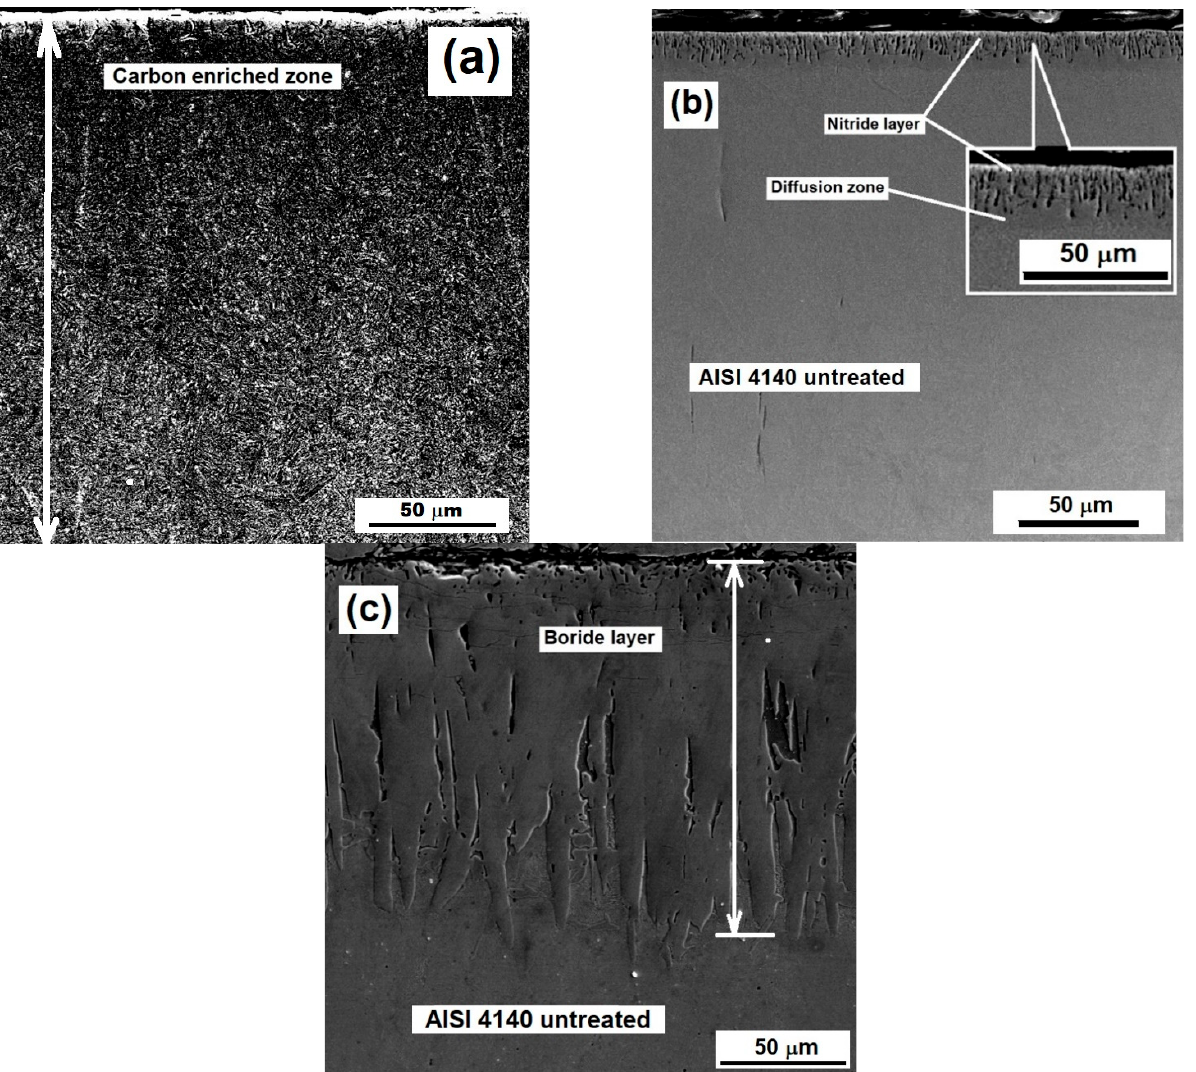
Figure 2. SEM images of the cross-sections of the samples exposed to ( a ) carburizing, ( b ) nitriding and ( c ) boriding.